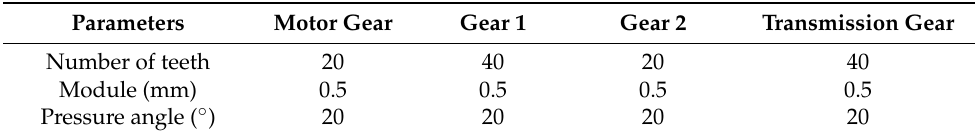
Table A1. Main parameters of gear